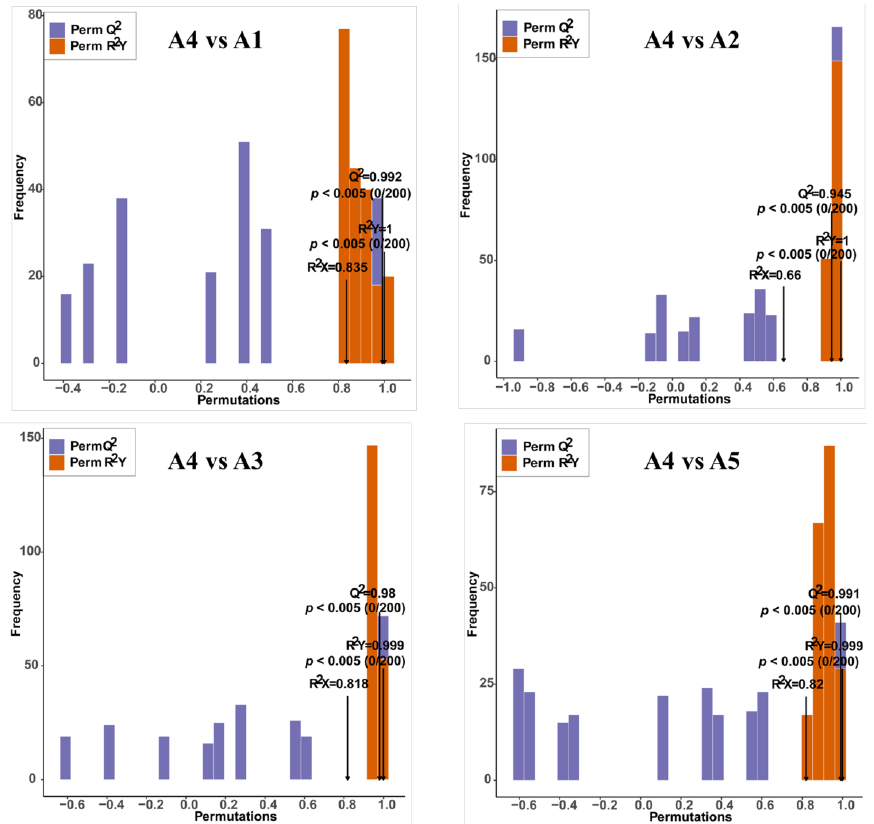
Figure 4. Orthogonal partial least-squares discriminant analysis (OPLS-DA) model of comparison groups, including A4 vs. A1, A4 vs. A2, A4 vs. A3, and A4 vs. A5. The differentially accumulated metabolites (DAMs) were further identified in pair- wise comparisons using the criteria of a fold cha nge ≥2 or ≤0.5 and a VIP (variable im- portance in project) ≥1. Compared with A4, possessing a white fruit peel color, a total of 156, 101, 145, and 150 DAMs were identified in A1 (black purple), A2 (green), A3 (black purple), and A5 (reddish purple), respectively (Figure 5A). As expected, most of the DAMs were upregulated in the other four varieties as the peel color changed from white to black purple. A total of 48 DAMs were observed among the comparison groups A4 vs. A1, A4 vs. A2, A4 vs. A3, and A4 vs. A5 (Figure 5B). For the reddish to black-purple group (A1 vs. A3, A1 vs. A5, and A3 vs. A5), the lowest number of DAMs was found for A1 vs. A5 (46 upregulated and 32 downregulated DAMs in A5). Compared with A3, a total of 146 DAMs (105 downregulated and 41 up- regulated) as well as 143 DAMs (99 downregulated and 44 upregulated) were observed in A1 and A5, respectively (Figure 5A). Most of the DAMs, including chalcones, fla- vanonols, flavonols, and tannins, were upregulated in A3. The differential metabolites among the five varieties were mapped to the Kyoto Encyclopedia of Genes and Genomes (KEGG) database, and a KEGG enrichment analysis was performed for the DAMs of each comparison group. The most enriched pathways detected for all compared groups were flavonoid biosynthesis, anthocyanin biosynthesis, flavone and flavonol biosynthesis, isoflavonoid biosynthesis, and the biosynthesis of secondary metabolites.